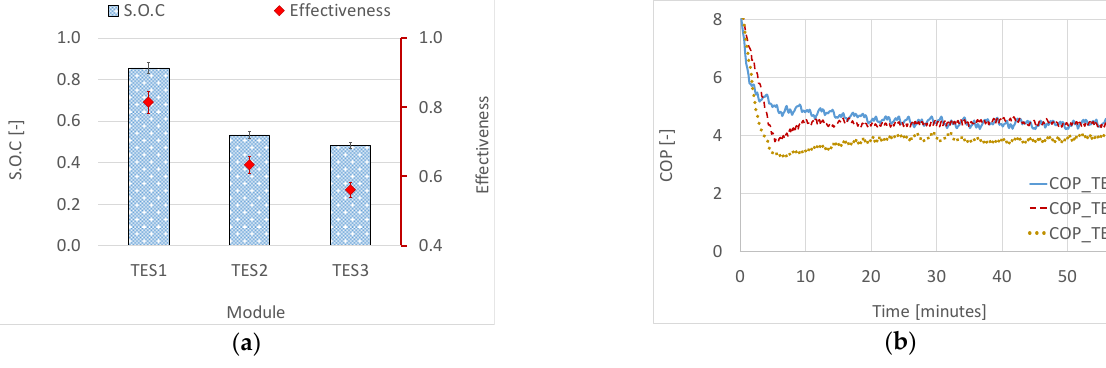
Figure 10. Results of three-fluids HEX mode: ( a ) energy level at thermal equilibrium and effectiveness and ( b ) COP of the refrigeration system against time.